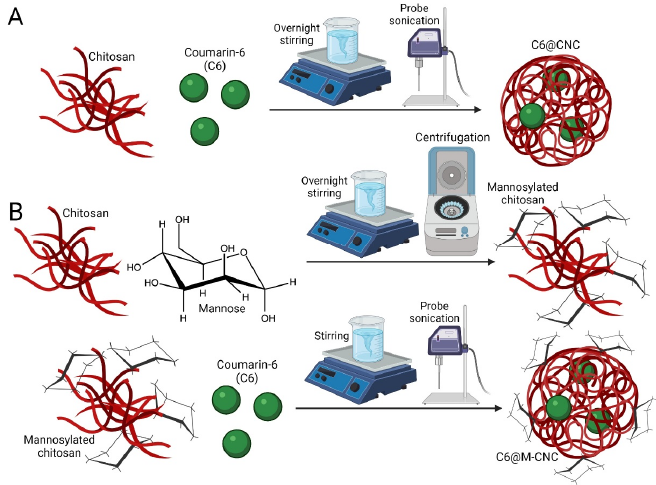
Figure 1. Reaction scheme for preparing: ( A ) C6@CNCs and ( B ) C6@M-CNCs.